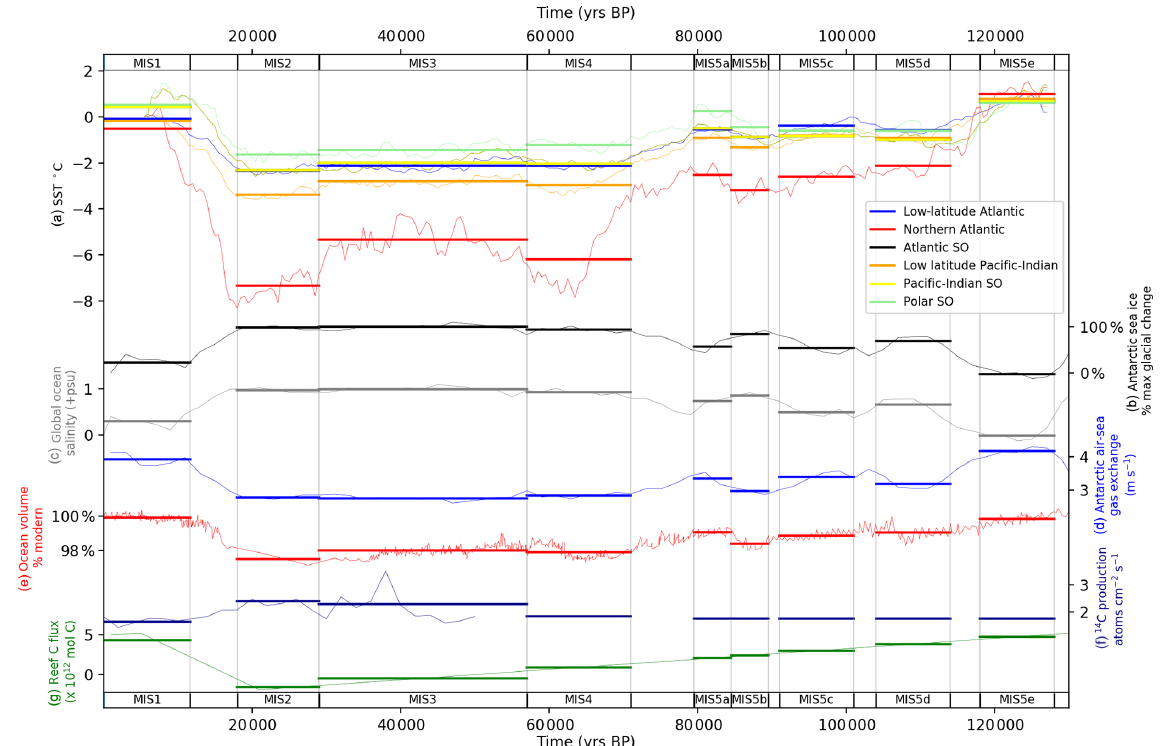
Figure 2. Model forcings for MIS across the last glacial–interglacial cycle. (a) Sea surface temperature reconstruction of Kohfeld and Chase (2017), mean values mapped into SCP-M surface boxes (fine lines) and averaged across MIS (bold horizontal lines). (b) Proxy for Antarctic sea-ice extent using ssNa fluxes from the EPICA Dome C ice core (Wolff et al., 2010), used to temporally contour MIS model forcings for (c) salinity (Adkins et al., 2002) and (d) polar Southern Ocean air–sea gas exchange. Global ocean salinity is forced to a glacial maximum of + 1psu (shown in a ) and the polar Southern Ocean is forced to + 2psu (not shown), as modified from Adkins et al. (2002). Ocean volume (e) forced using global relative sea level reconstruction of Rohling et al. (2009). (f) Atmospheric 14 C production rate time series for 0–50ka of Muscheler et al. (2014). Long-term values assumed for > 50ka (Key, 2001). (g) Shallow-water carbonate flux of carbon from Ridgwell et al. (2003) profiled across the glacial–interglacial cycle using a curve from Opdyke and Walker (1992). Fine lines are the time series data and bold lines are the model forcings in each MIS. Data behind the figure are shown in Tables S2 and